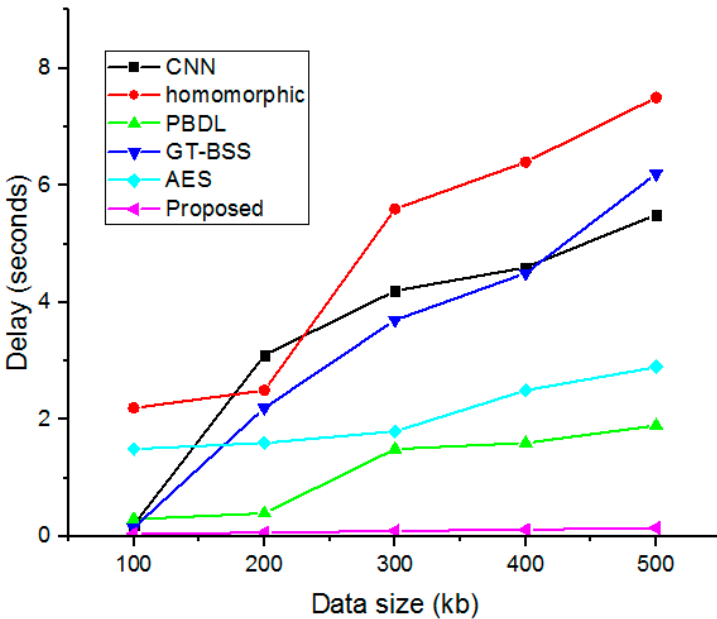
Figure 13. Delay estimation for complete data